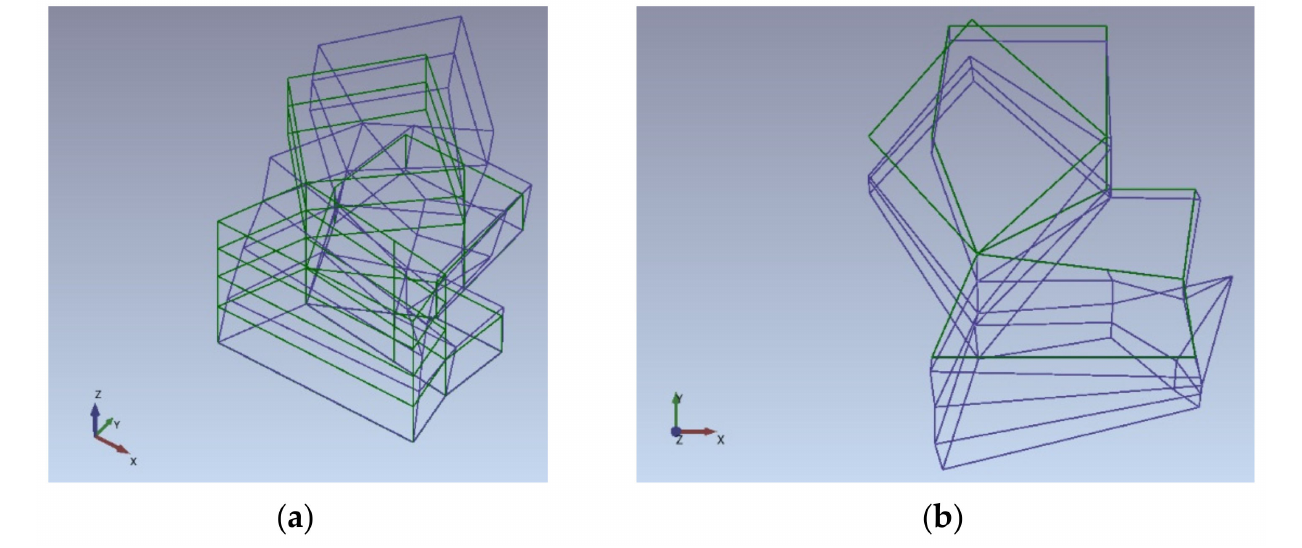
Figure 13. Third experimental mode is a torsional-bending mode along y axis (in green the un- deformed configuration and in blue the mode shape): ( a ) 3D view; ( b ) plan view.